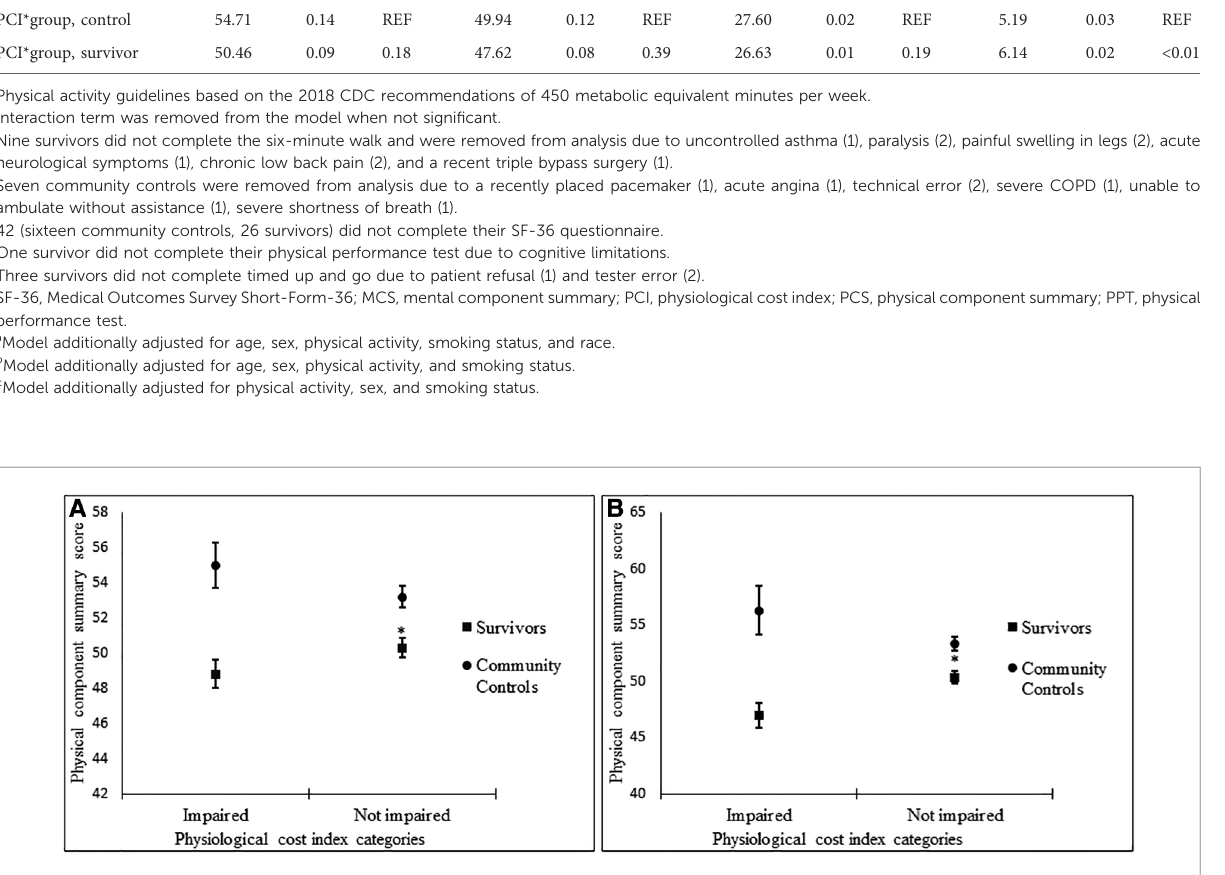
FIGURE 1 Associations between impaired vs. not impaired physiological cost index and physical component summary score ( A ), severely impaired vs. not impaired physiological cost index, physical component summary score ( B